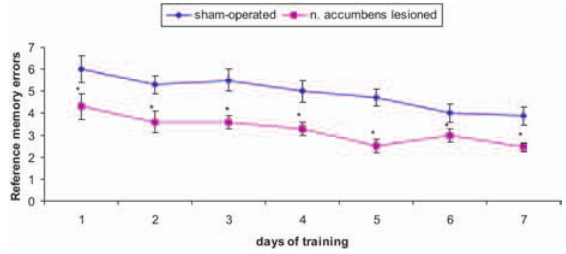
Figure 1. Cell cytotoxicity after exposure of the HUVEC cultures to solid samples of biomaterials for 24, respective 72 hours (results are shown as % of untreated controls). Panel is representative of three independent experiments, * represents the value of p, respective *=p<0.05; **= p<0.005; *** =0.05<p>0.005; p ≤ 0.05 was considered